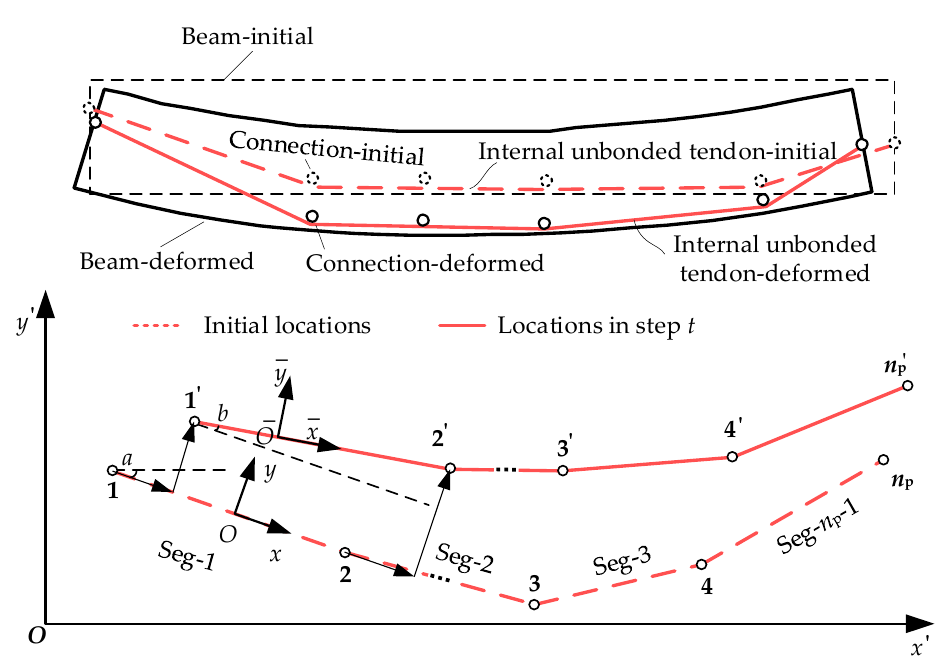
Figure 5. Schematic diagram of multi-node slipping cable element for internal unbonded tendon. At step t , we express the element displacement vector U t as Equation (3).